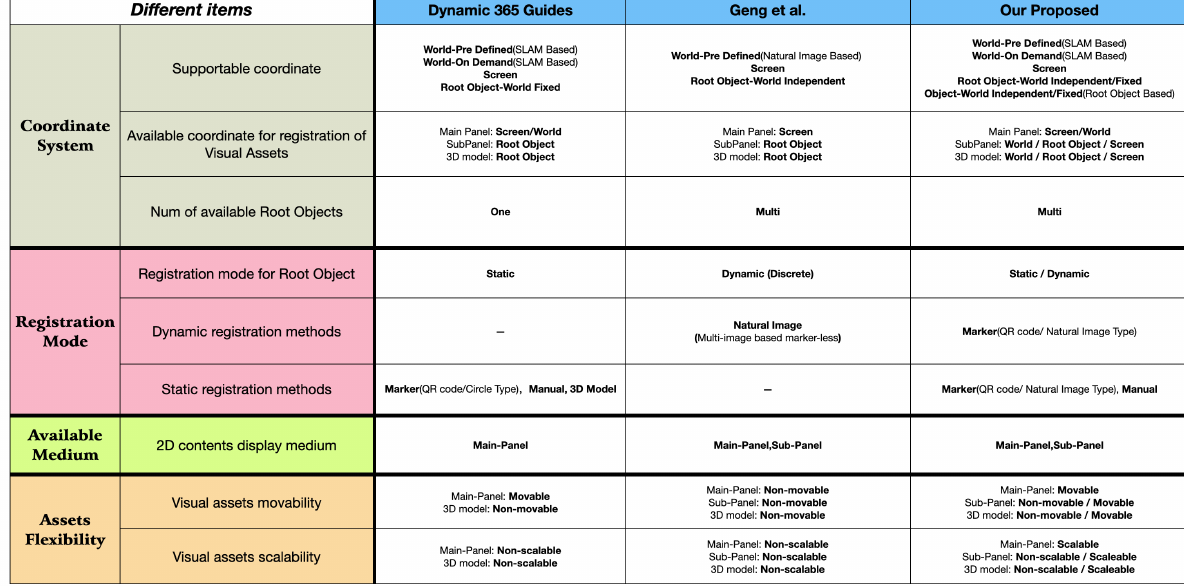
Figure 2. Comparison of conventional AR support software platform with our proposed high-degree- of-freedom visualization methods